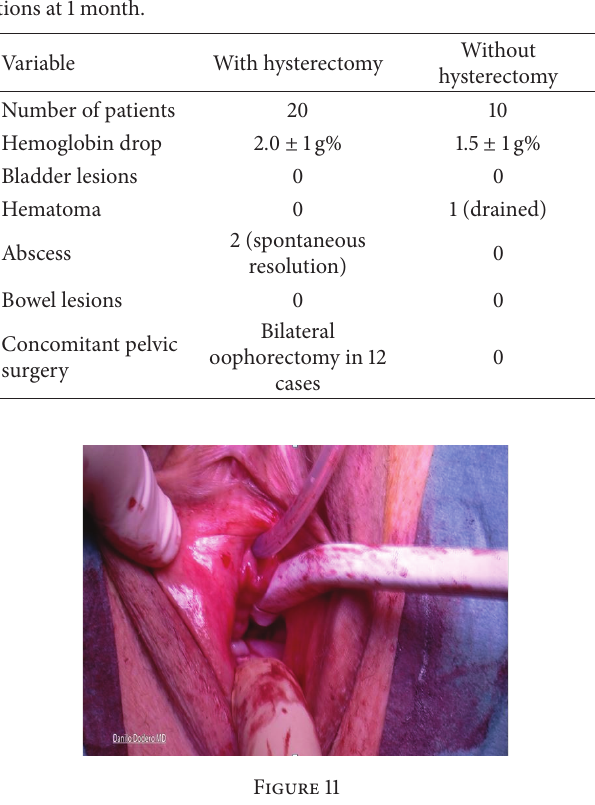
Table 3: POP-Q findings.